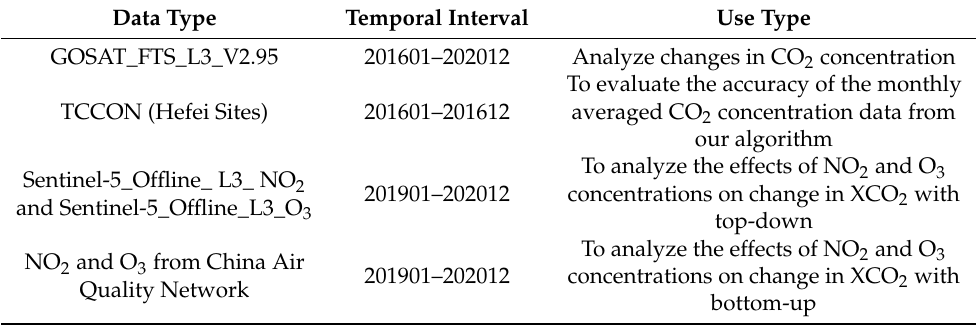
Table 1. Overview of